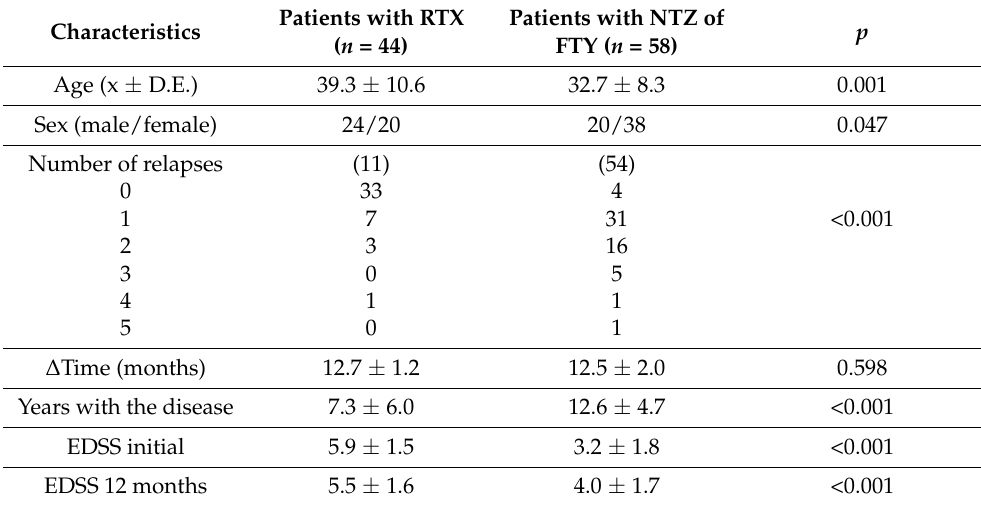
Table 1. Sociodemographic and clinical characteristics of MS